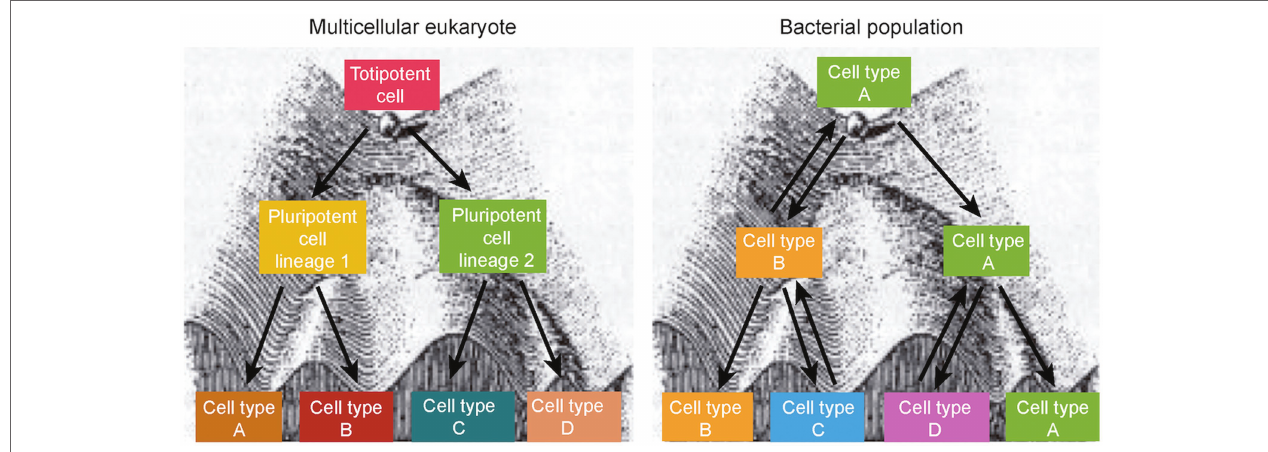
FIGURE 5 | Adaptation of Waddington’s artistic drawing of an epigenetic landscape as a ball that falls to stable valleys from unstable ridges. In multicellular eukaryotes, the differentiation capacity is narrowed down at each intersection, and development proceeds in an orderly manner (left). In a bacterial epigenetic landscape, loss of differentiation capacity does not occur at any intersection, and formation of cell variants follows an aperiodic behavior typical of deterministic nonlinear systems